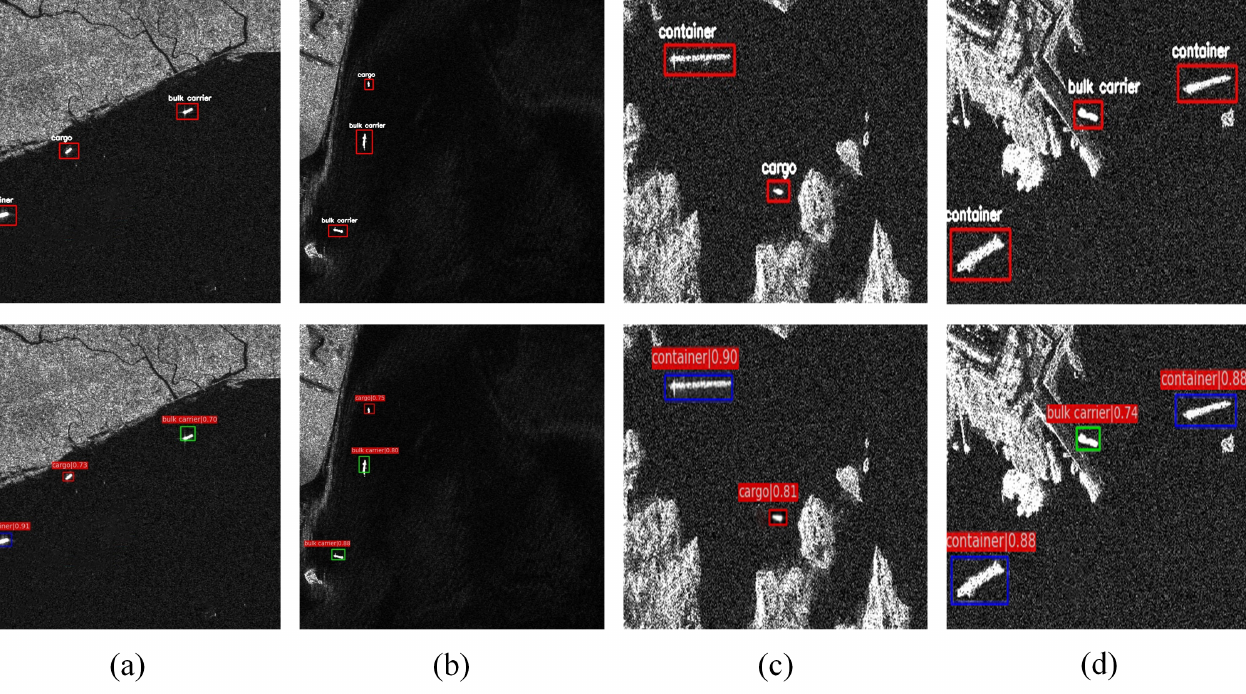
Figure 7. Nearshore background ship target experiments. All images at the top are images with truth boxes, and the images at the bottom are images of the detection results of our